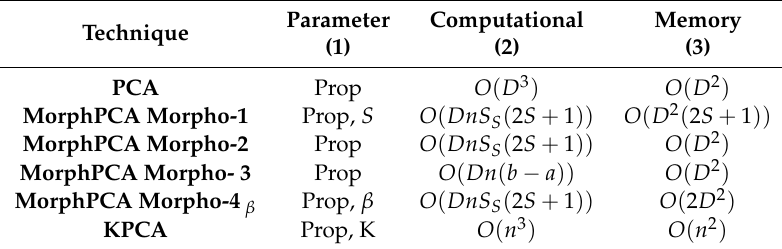
Table 1. Comparison of the properties of dimensionality reduction algorithms for hyperspectral